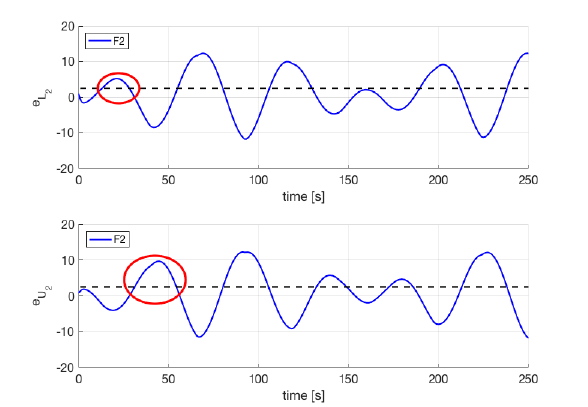
Figure 4. Fault F1 scenario. Residual signals e U the dashed line, a fault is detected.